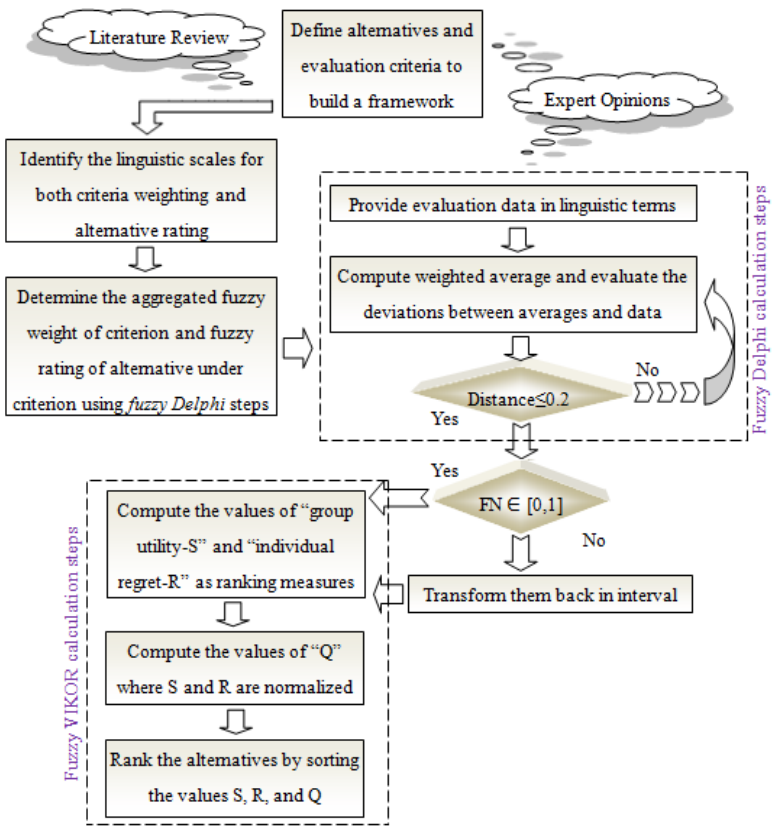
Fig. 2. Proposed methodology of the